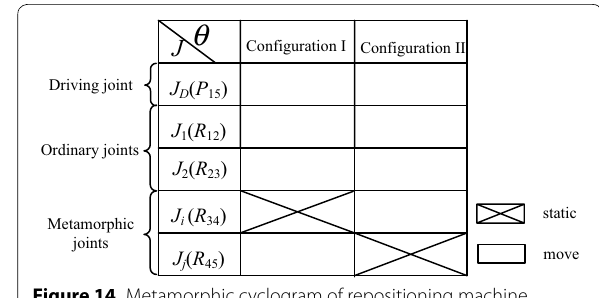
Figure 14 Metamorphic cyclogram of repositioning machine gradient sketch